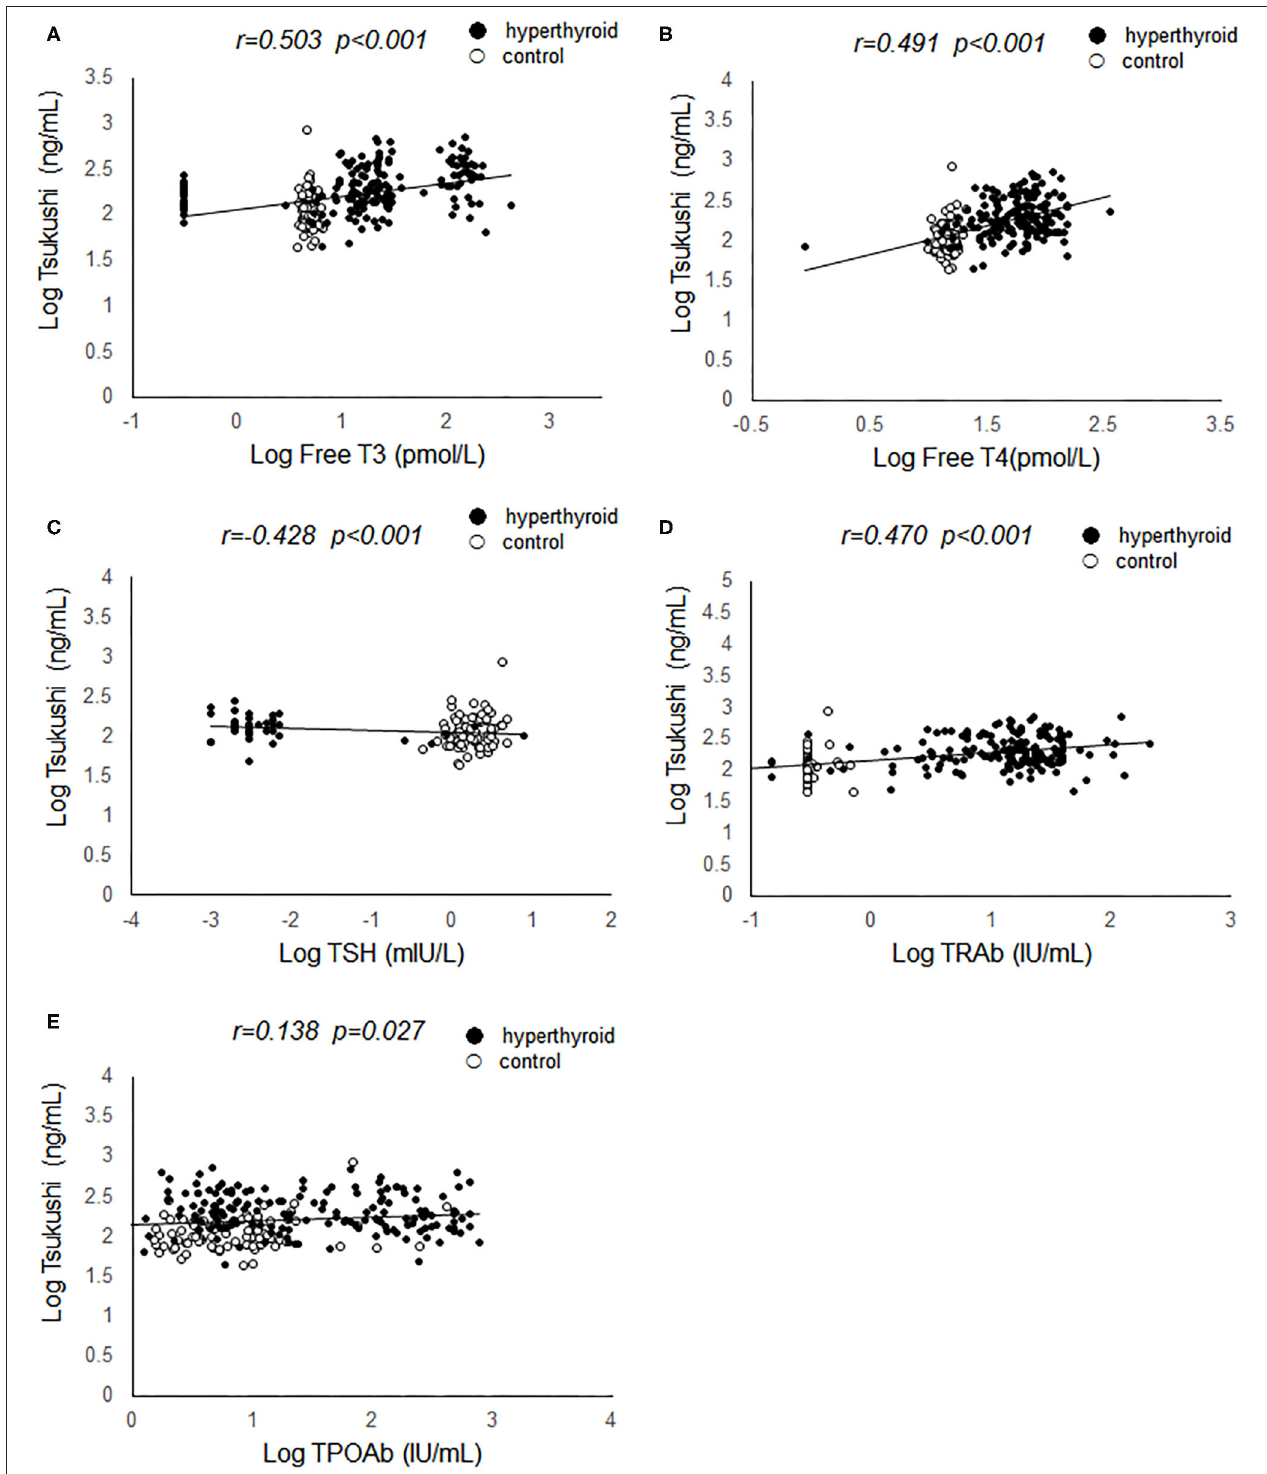
FIGURE 1 | Correlation of serum Tsukushi levels with thyroid function. (A) Correlation of serum Tsukushi levels with serum levels of free T3; (B) correlation of serum Tsukushi levels with serum levels of free T4; (C) correlation of serum Tsukushi levels with serum levels of TSH; (D) correlation of serum Tsukushi levels with serum levels of TRAb; (E) correlation of serum Tsukushi levels with serum levels of TPOAb; T3, triiodothyronine; T4, thyroxine; TSH, thyroid stimulating hormone; TPOAb, thyroid peroxide antibody; TRAb, thyrotropin receptor antibody.